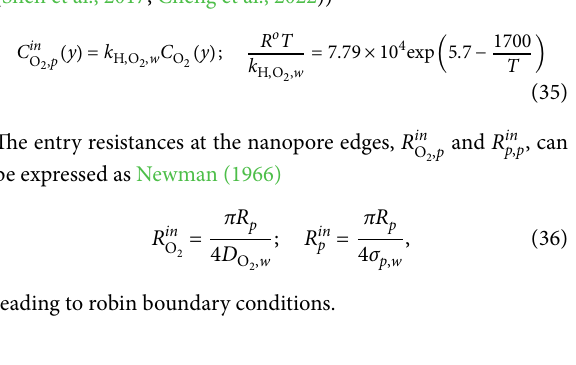
Figure 6A : 1 ) baseline case devoted to the geometrical optimization of the CL microstructure (see optimization